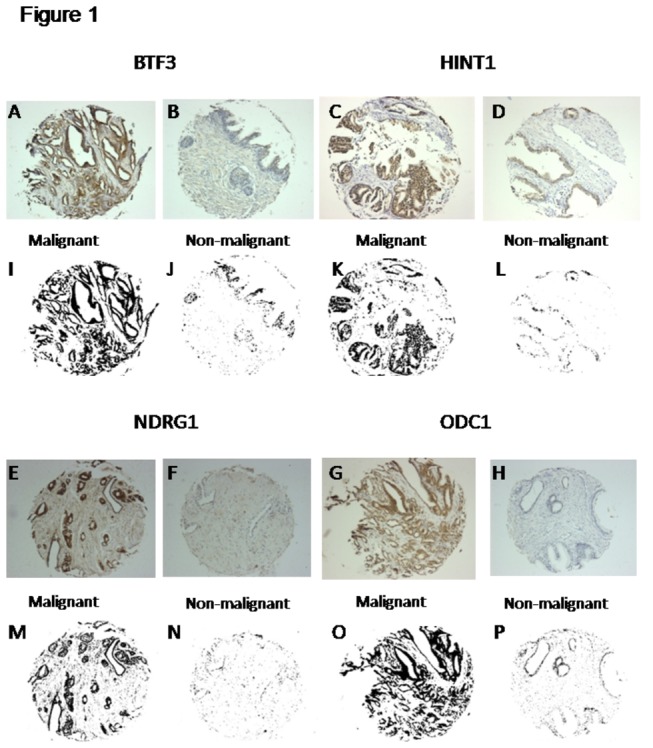
DAB-HRP tissue staining for BTF3, HINT1, NDRG1 and ODC1 in representative malignant (A,C,E,G) and non-malignant (B,D,F,H) prostate tissue cores(of over 500 tissue cores stained for each antibody) from human prostate arrays. These are representatives of over 450-500 tissue core images analyzed for each biomarker antibody using the automated image analysis protocol (see Materials and Methods – Image particle analysis). Each core was imaged using a Leica upright microscope (10x) and saved as a jpg file. Each image was used to calculate protein expression (DAB label, brown, largely in acinar cells). Colored RGB images (A-H) were converted to corresponding grayscale images (I-P) for the quantification of the DAB signal using Analyze Particle protocol in ImageJ software to obtain Total Area stained, in pixel. Protein expression for BTF3, HINT1, NDRG1 and ODC1 was increased in malignant v benign cores (p<0.0001).